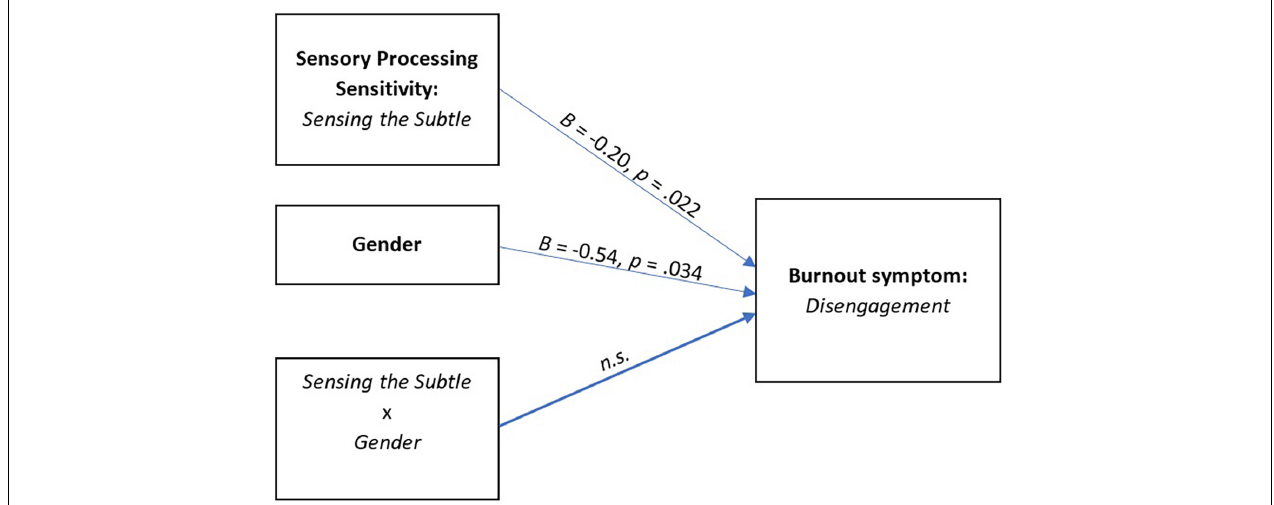
FIGURE 4 | Model of the relations between sensory processing sensitivity ( Sensing the Subtle subscale) and burnout symptoms ( Disengagement subscale), moderated by gender ( n.s. , not